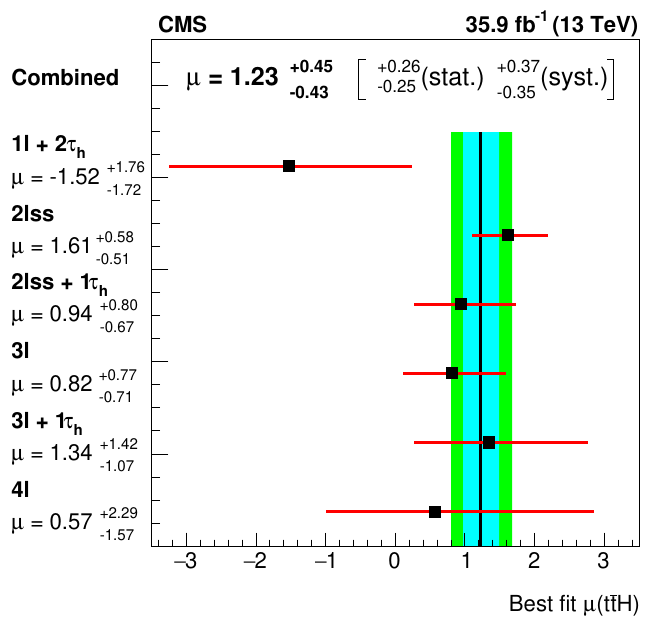
Figure 6 . Signal rates (cid:22) , in units of the SM ttH production rate, measured in each of the categories individually and for the combination of all six categories. The blue (green) band corresponds to the statistical (total) uncertainty on the combined signal